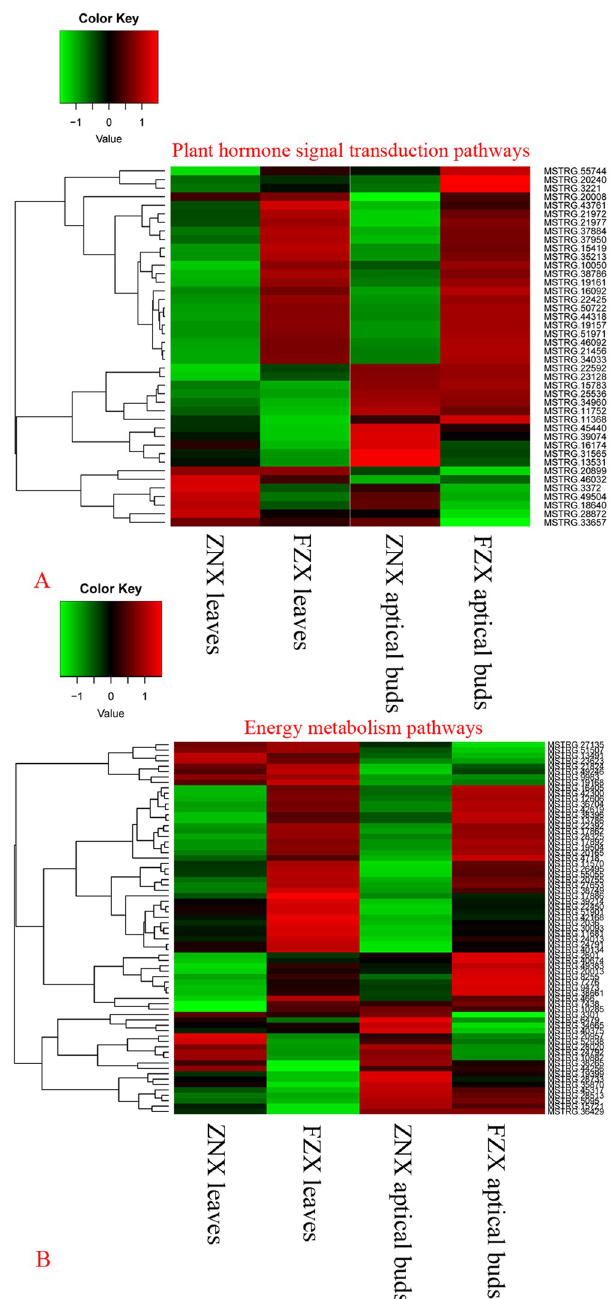
Fig 6. Heat map diagram of relative gene expression levels of DEGs related to plant hormone signal transduction pathways (A) and energy metabolism pathways (B).